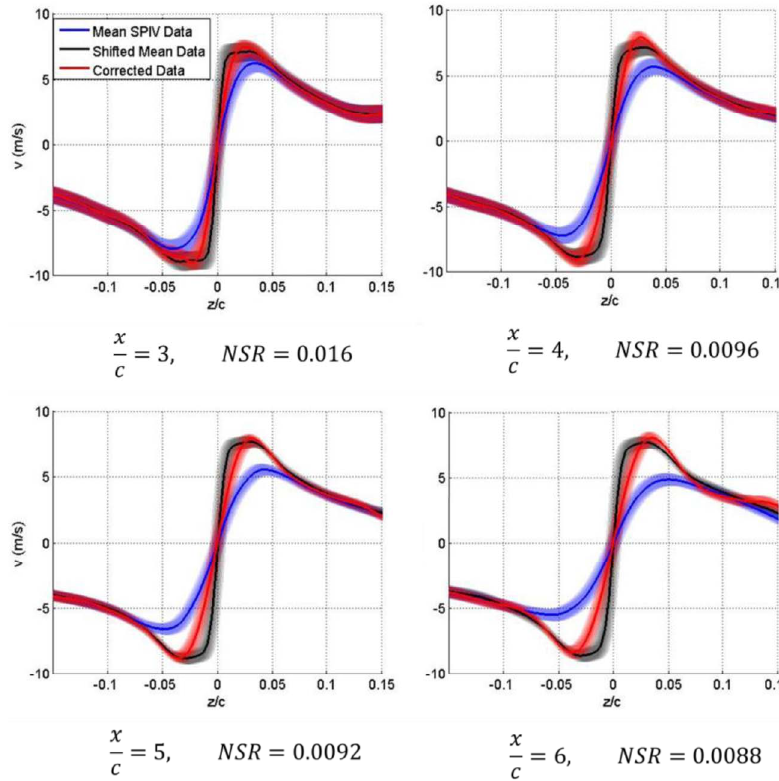
Figure 7 - Corrected azimuthal velocity